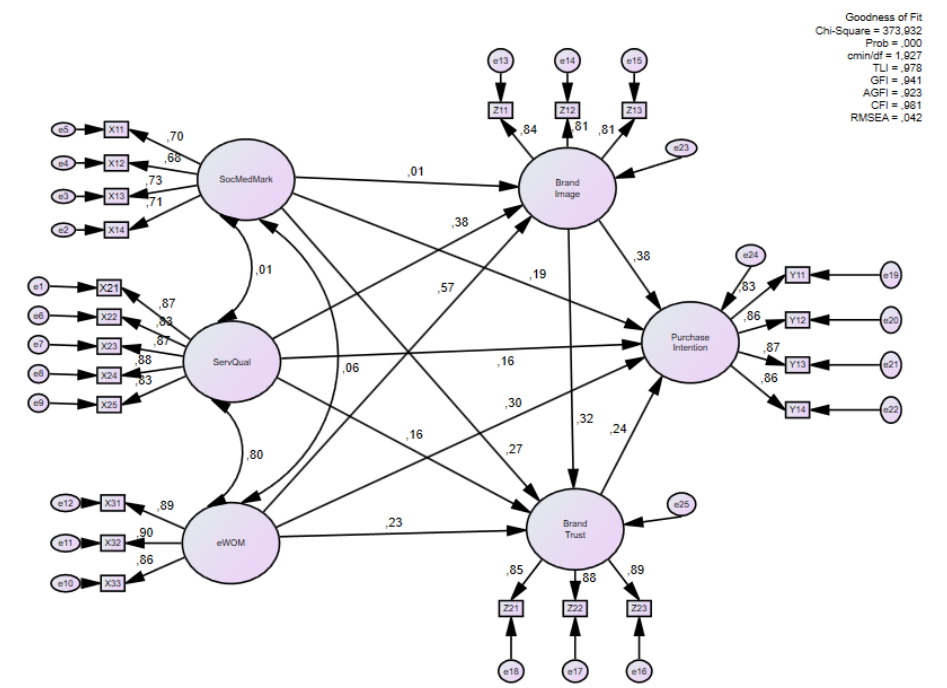
Fig. 1. Results of structural equation